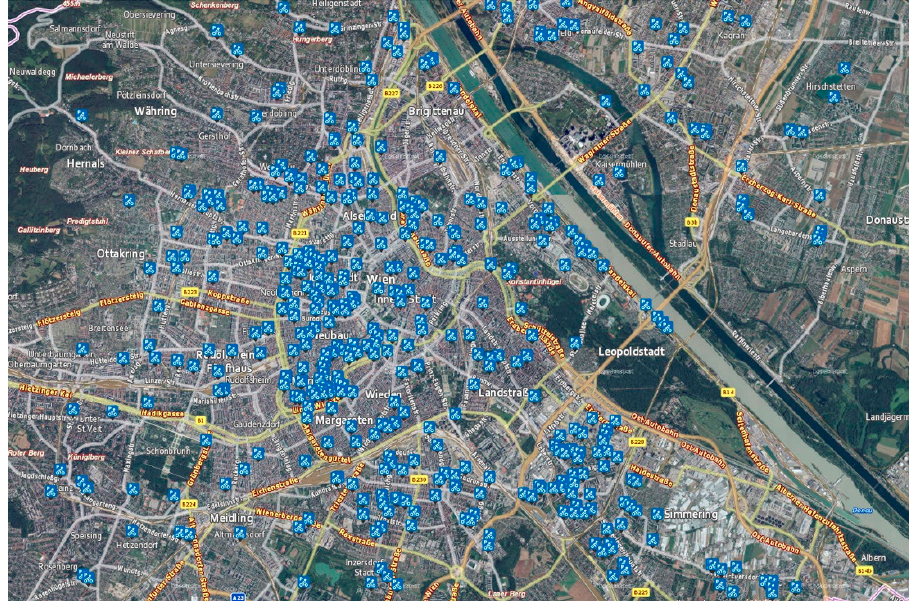
Figure 7. Distribution of parking zones for motorbikes within Vienna. Source: https://m.wien.gv.at/stadtplan/#base=luft&layer=motorradabstellplatz&zoom=13&lat=48.2095&lon=16.417 (accessed on 9 February 2021).